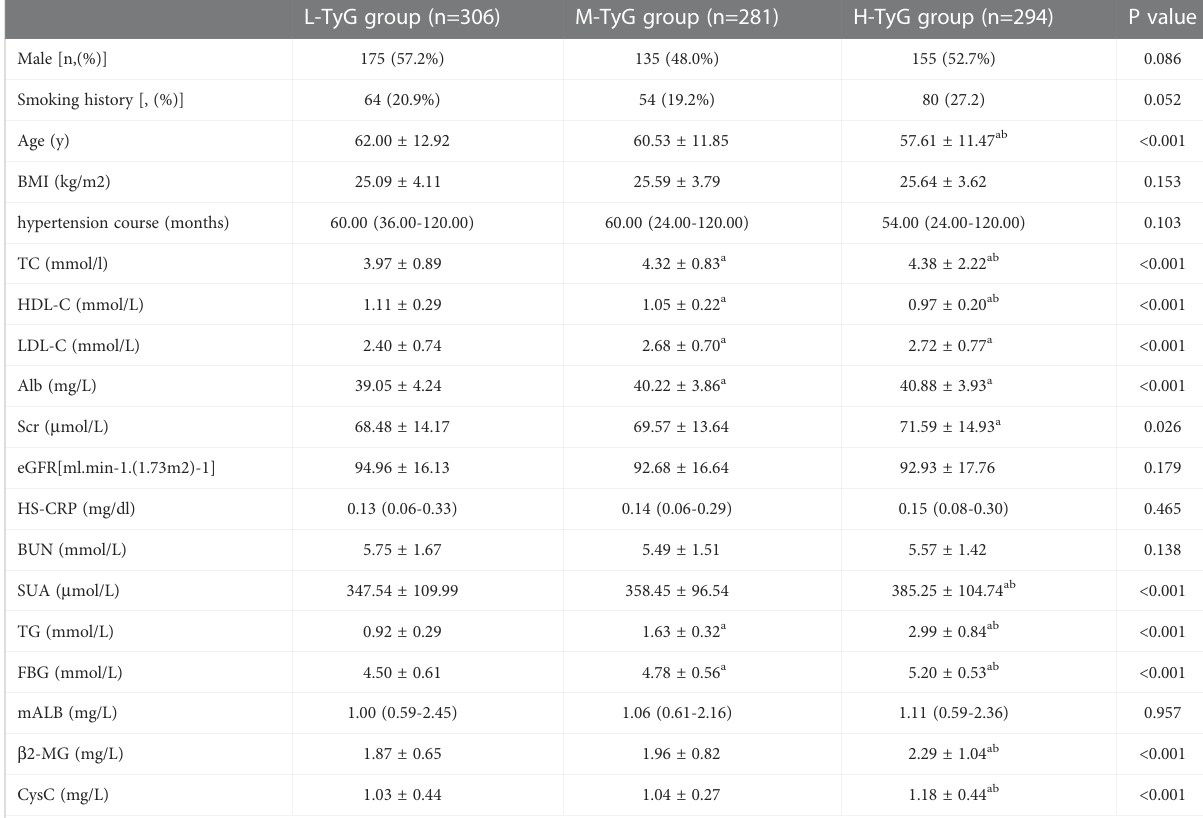
TABLE 1 Comparison of general data and clinical indicators of the L-TyG group, M-TyG group, and H-TyG. L-TyG group